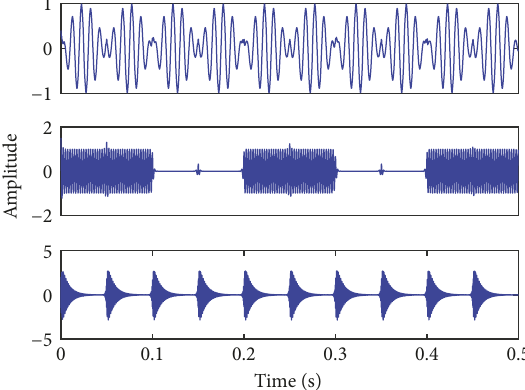
Figure 5: CEELMDAN decomposition results.